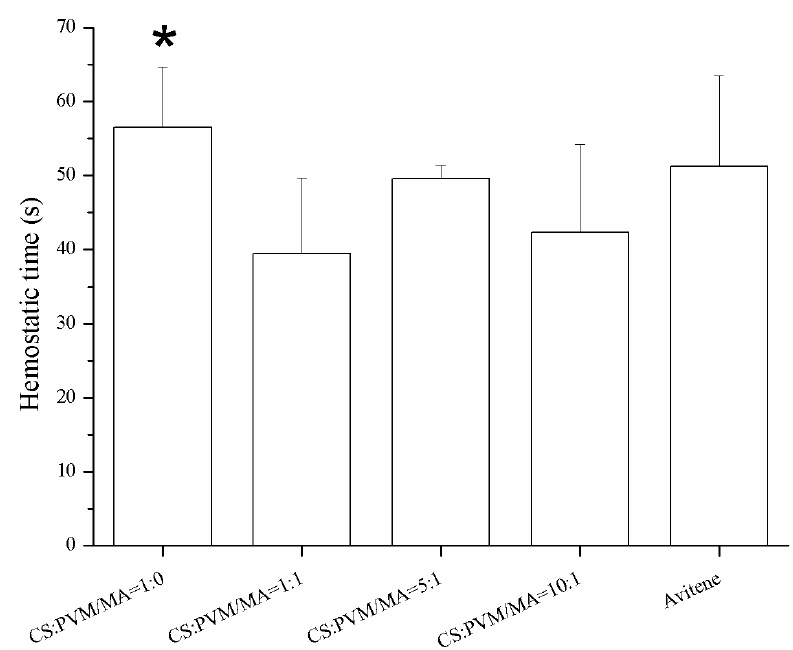
Figure 9. Hemostasis time of different sponges on mouse femoral artery. The “*” indicates a significant difference between the prepared sponge and Avitene ( p < 0.05, Student’s t-test, n =